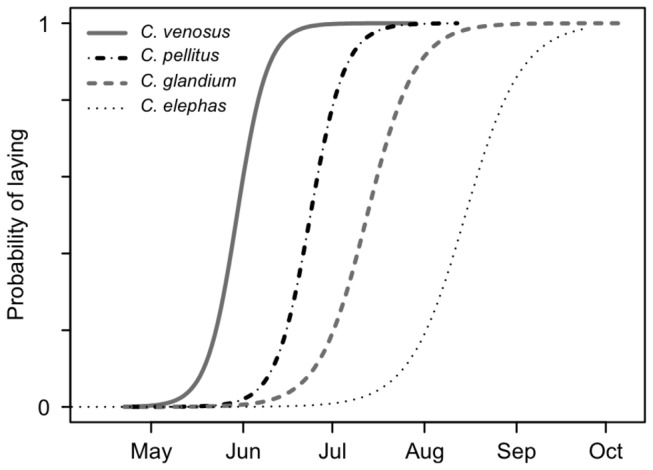
Seasonal time partitioning among the four competing species.The logistic regression models of laying probabilities over time significantly differ among the four species. Only mated females with mature oocytes are considered as being ready to lay (probability=1). Virgin and/or immature females (i.e., with no ovarian development) are considered to have a null probability of laying.